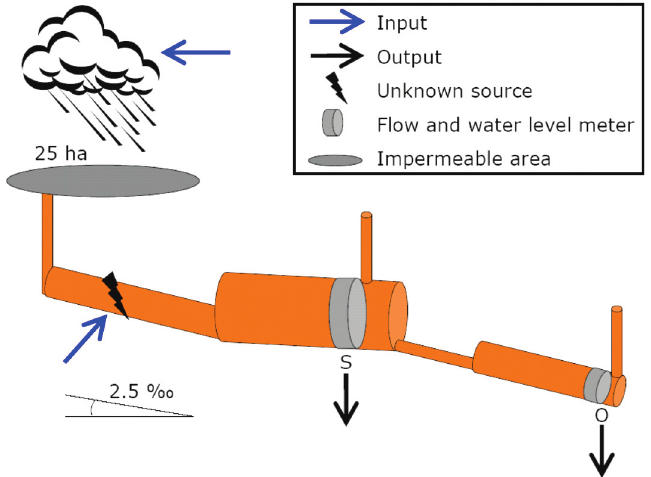
Figure 3. Illustration of the model setup for the hypothetical example along with input and output